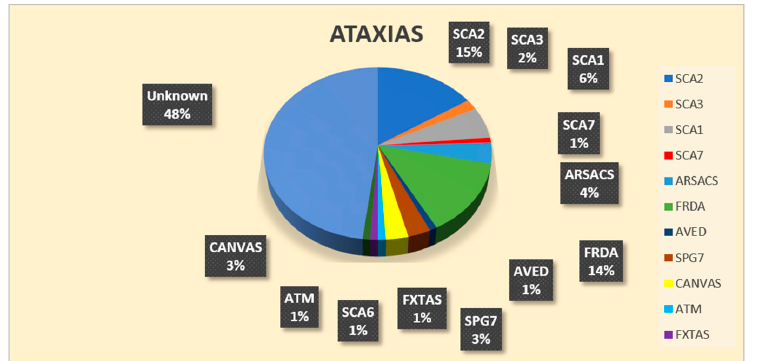
Figure 4. Pie-chart showing the results of individual gene screening on the group degenerative ataxias. A molecular diagnosis was assessed in 52% of the whole cohort. In black boxes the relative percentages for each molecular diagnosis are reported; SCA2 and Friedreich’s ataxia were the most common genetic